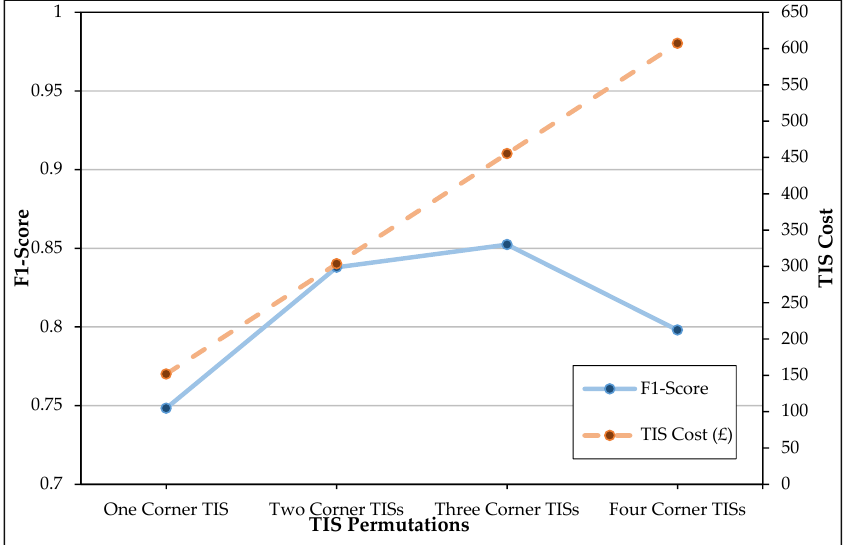
Figure 7. Trade-off between the number of TISs and random forests, performance and cost of the TISs. Figure 7. Trade-o ff between the number of TISs and random forests, performance and cost of the